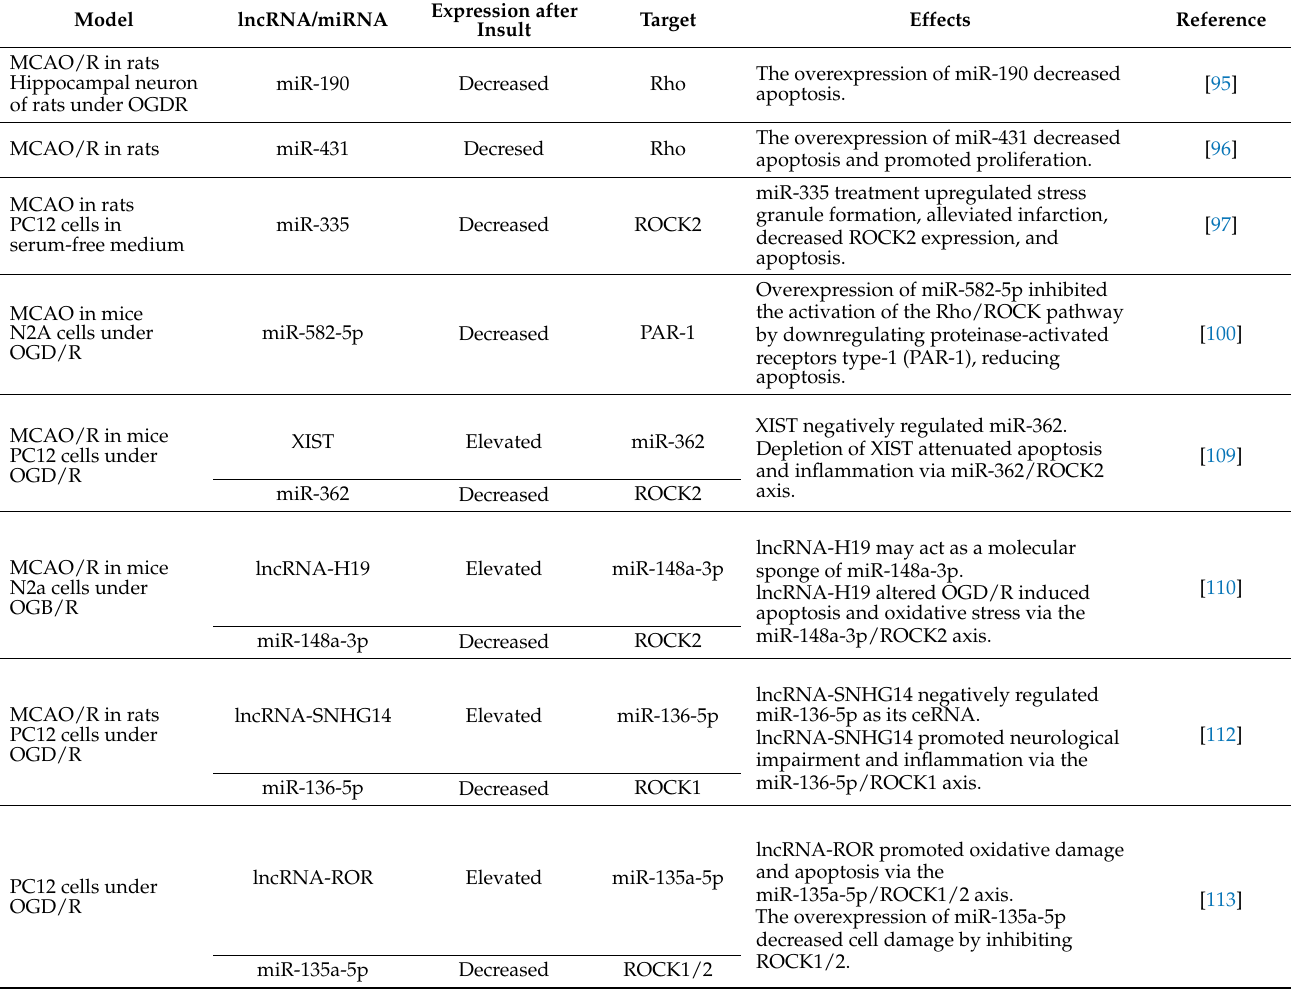
Table 1. LncRNAs/miRNAs and the Rho/ROCK pathway in ischemic